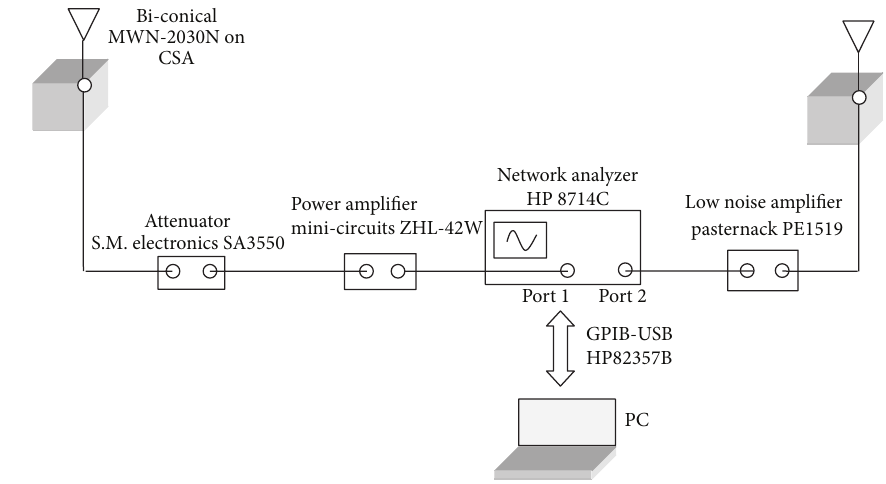
Figure 2: Measurement system configuration.